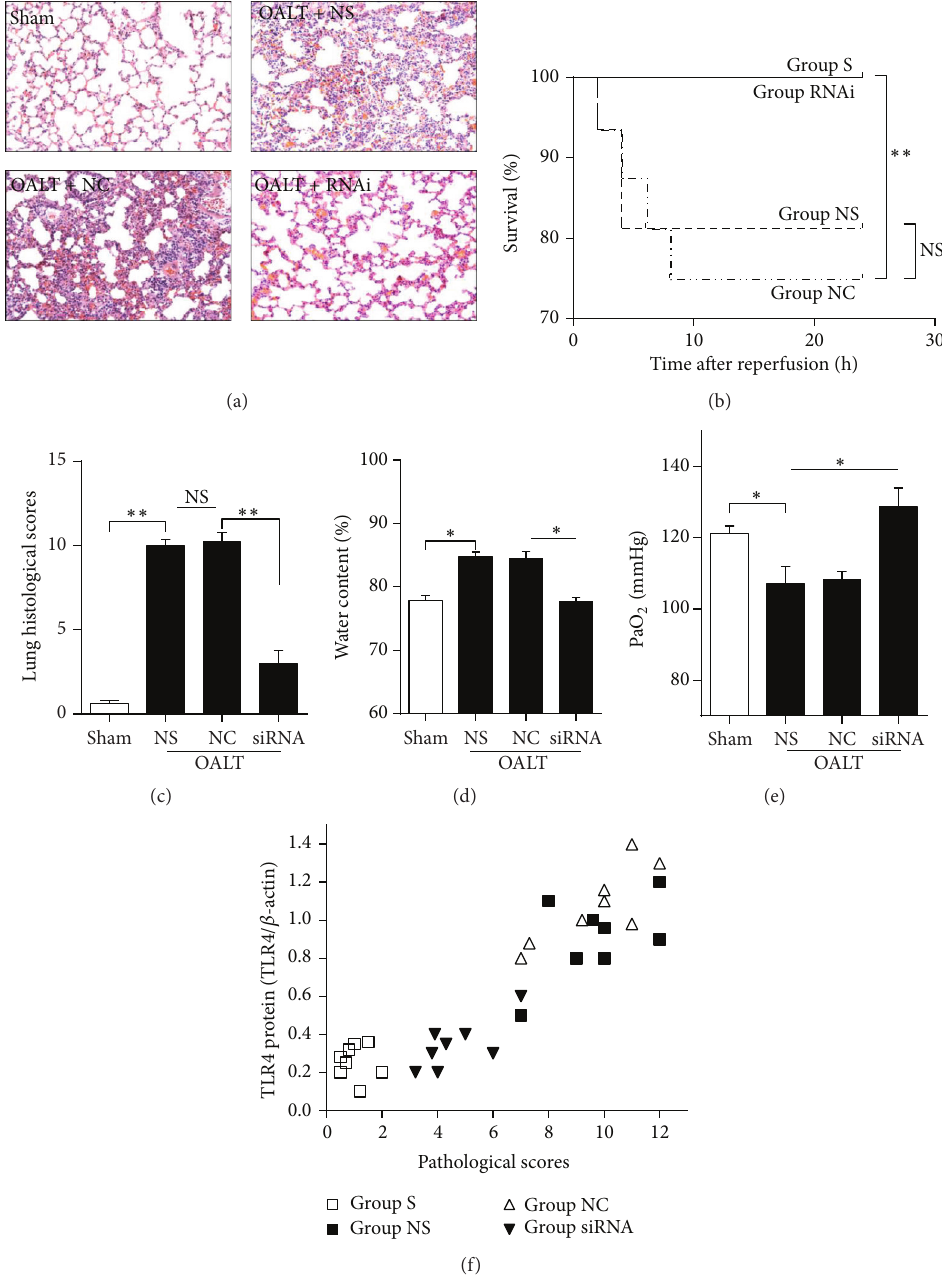
Figure 5: TLR4 siRNA reduced lung injury and resulted in an improvement of pulmonary function and rats survival. The effect of TLR4 siRNA on lung pathological change (a and c). Effect of TLR4 siRNA on survival (b). Survival time is calculated from the beginning of liver reperfusion. Results were compared by Kaplan-Meier log rank test and Fisher exact test, 𝑛 = 14 . (d) and (e) showed the effect of TLR4 siRNA on pulmonary function evidenced by lung water content and PaO 2 . (f) showed correlations between TLR4 protein levels and pathological scores. Groups S, NS, NC, and siRNA were treated with nothing, saline, negative control siRNA, and targeting siRNA, respectively. Values were expressed as mean ± SEM. NS: no statistical significance; ∗ 𝑃 < 0.05 , ∗∗ 𝑃 < 0.01 , one-way ANOVA with Tukey